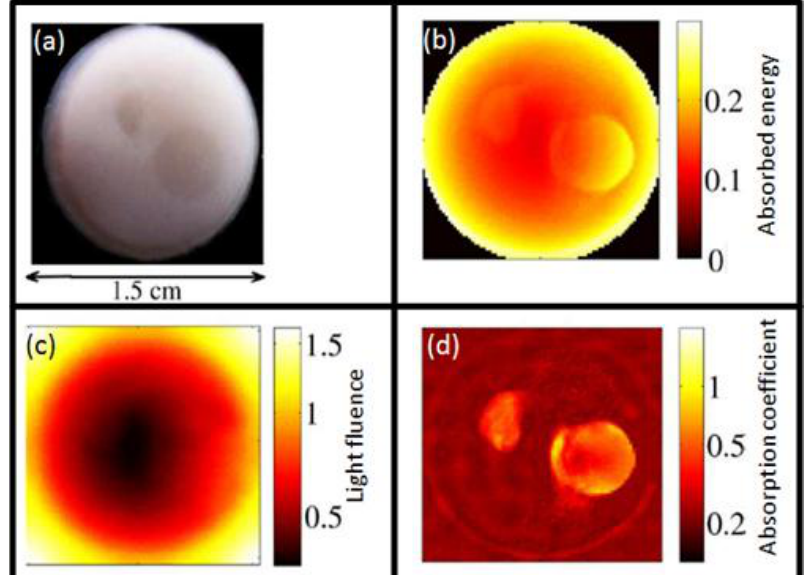
Figure 9. Sparse decomposition of an OA reconstruction presented by Rosenthal et al. to determine both the light fluence and the absorption coefficient [143]. ( a ) Schematic description of the phantom used; ( b ) OA reconstruction of the deposited heat in the phantom; ( c ) Recovered light fluence represented sparsely in a Fourier basis; ( d ) Recovered absorption coefficient represented sparsely by Haar